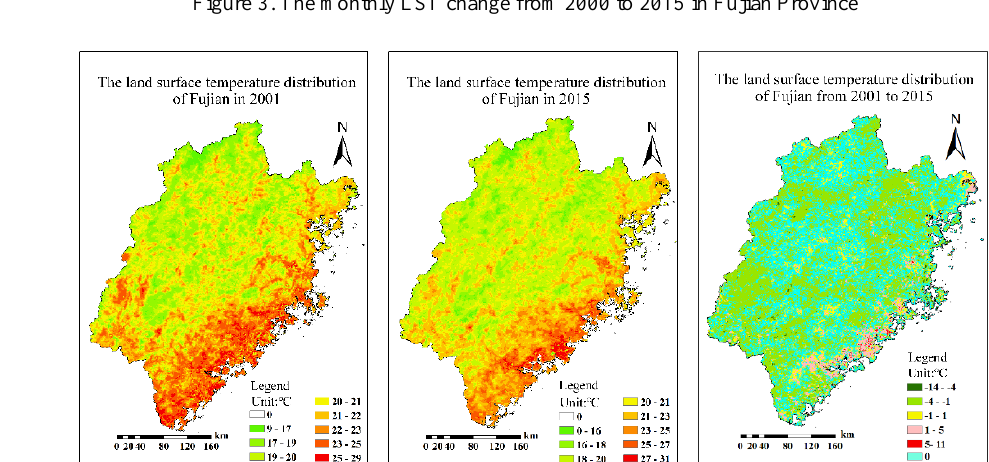
Figure 3. The monthly LST change from 2000 to 2015 in Fujian Province